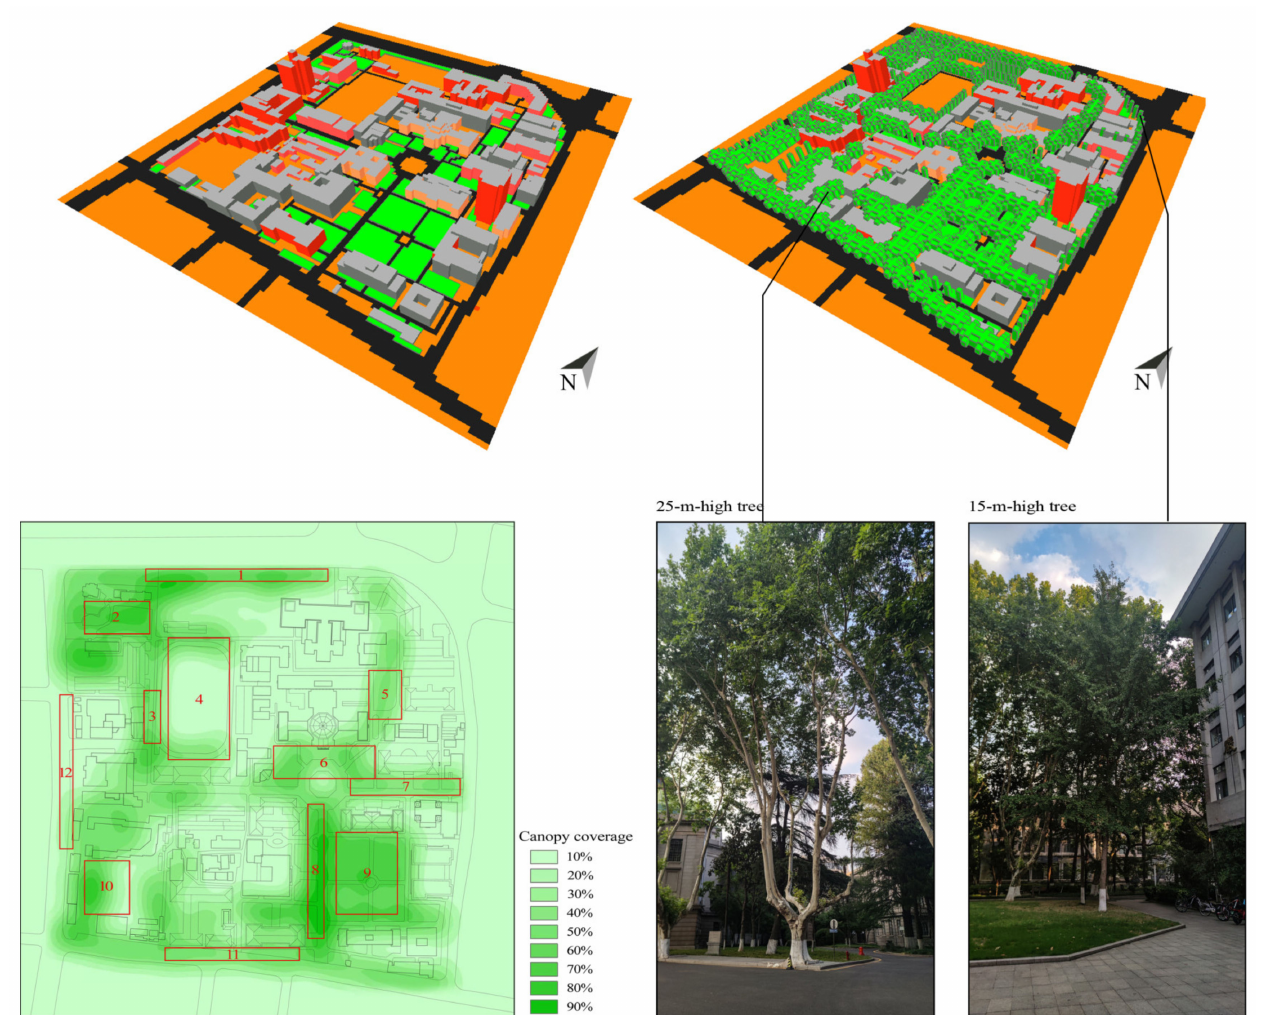
Figure 4. 3D bird’s eye view of two control models and specific information for 12